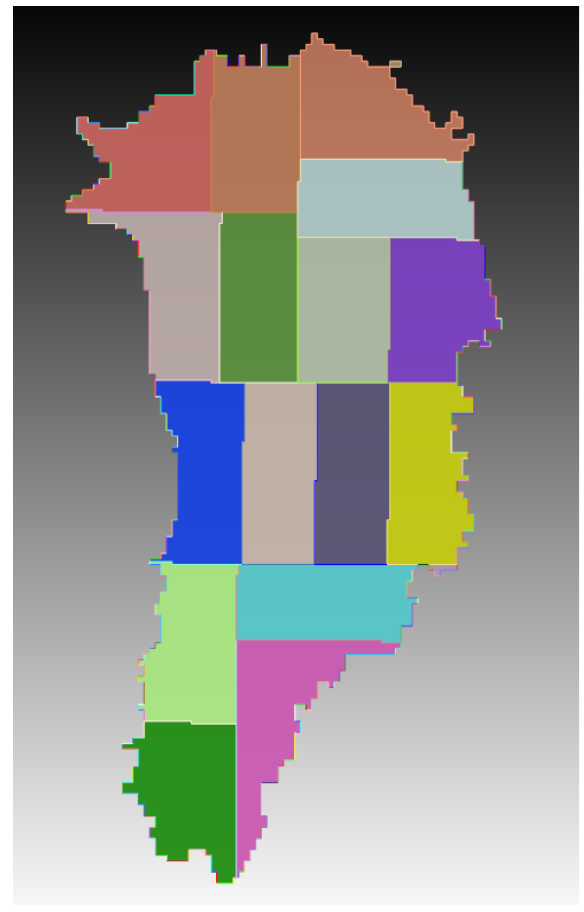
Figure 10. GIS domain decomposition for 16 core, parallel run, with different colors representing portions of the domain owned by different